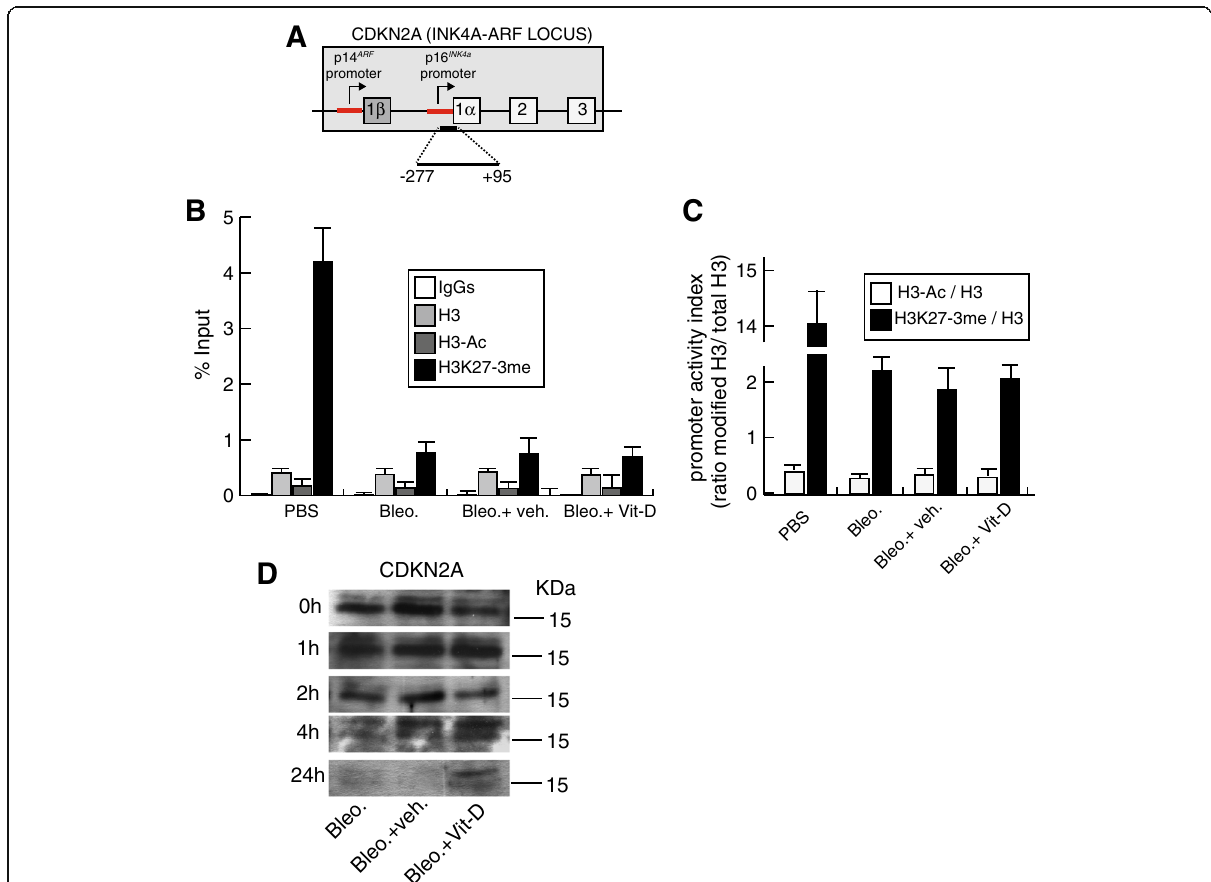
Fig. 6 Chromatin immunoprecipitation (ChIP) analysis of the CDKN2A (p16 INK4a ) proximal promoter. a Diagram (not to scale) that illustrates the CDKN2A ( INK4A-ARF ) locus showing its exon/intron structure and the region analyzed corresponding to the proximal p16 INK4a promoter (region − 277 to + 95). b ChIP result (% of input) obtained with normal IgGs, and the antibodies directed against histone H3 (H3), acetylated histone H3 (H3-Ac) and Histone H3 trimethylated in Lys27 (H3K27-3me). Cells were pretreated with vitamin D or its vehicle, subjected to a bleomycin shock (12 μ g/mL for 6 h) and then treated with 5 nmol/L vitamin D or its vehicle. Control cultures correspond to cells treated with bleomycin vehicle (PBS). c Promoter activity index as determined by the ratio of the % input of modified histone H3/ % input of total histone H3. Transcriptional activation is determined by the ratio H3Ac/H3 and repression by the corresponding ratio H3K27-3me/H3. The results presented in the graphs are means ±SEM. ANOVA P < 0,0001. d Determination of CDKN2A protein half-life. Cells were pretreated with 5 nmol/L vitamin D or its vehicle, subjected to a bleomycin shock (12 μ g/mL for 6 h) and then treated with 5 nmol/L of vitamin D or vehicle for 24 h. After that the cells were incubated with 100 μ M of cycloheximide for 24 h. Detection of CDKN2A protein was performed in cell extracts of cultures released from cycloheximide inhibition at different times (from 0 to 24 h). KDa: